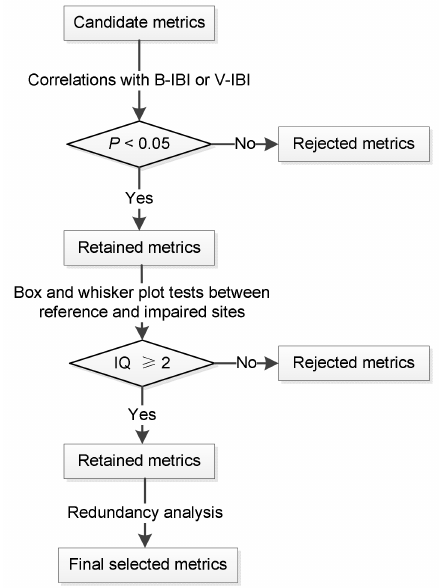
Figure 2. The procedure for selecting metrics of the landscape-based health index. B-IBI, benthic macroinvertebrate-based index of biotic integrity; V-IBI, vegetation-based index of biotic integrity; IQ, interquartile range